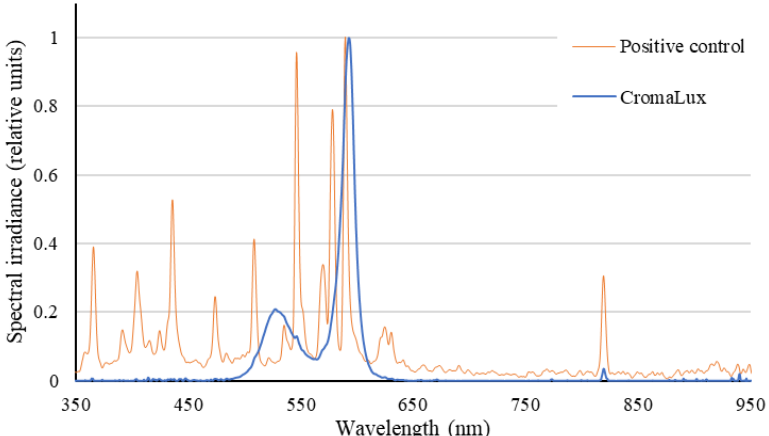
Figure 3. Normalised spectra of the CromaLux lamp with a CCT of 3000 K (blue line) and the metal halide lamp with a CCT of 4668 K (orange line). No significant differences were found between the mean values of light intensity in luxes of both lamps in the surrounding areas where the insects were trapped. The spectral sensitivity range of insects is 330 – 640 nm [38].